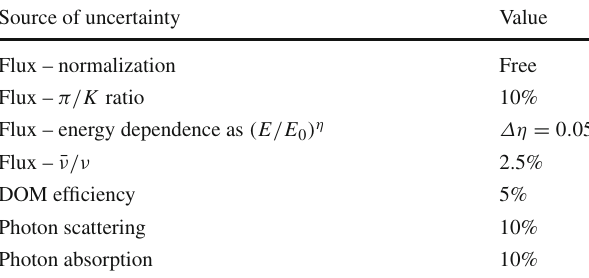
Table 1 The most relevant systematic errors used in our analysis of IceCube data, taken from Refs.